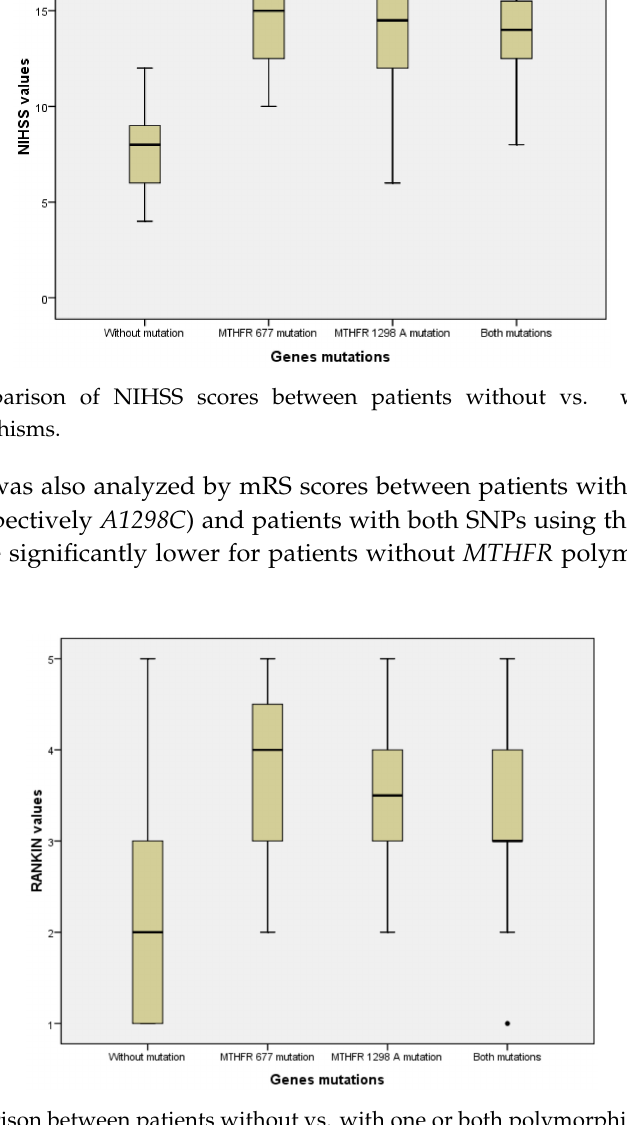
Figure 10. Comparison between patients without vs. with one or both polymorphisms of the MTHFR gene regarding mRS